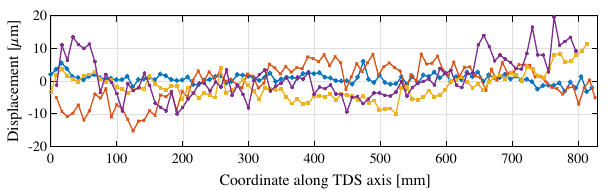
FIG. 23. Four straightness measurements along the TDS structure performed with a laser tracker (different colored lines).